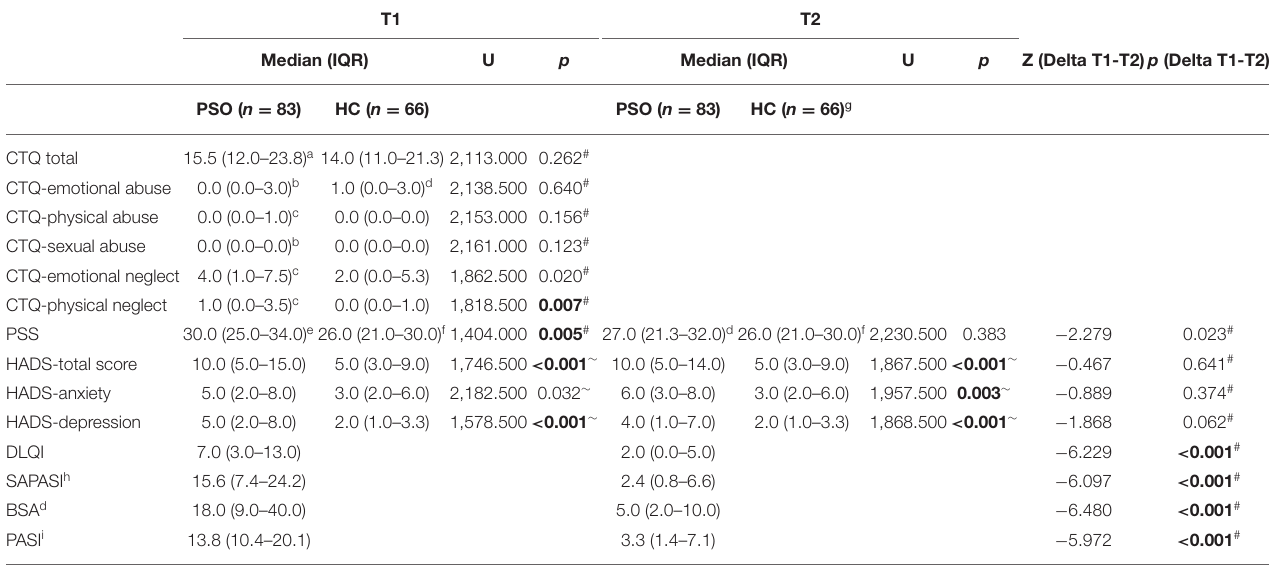
a 11 missing values. b 12 missing values. c 10 missing values. d 3 missing values. e 18 missing values. f 5 missing